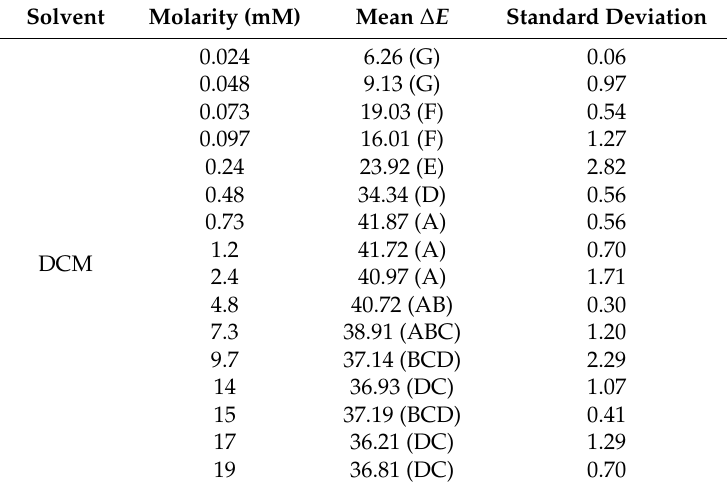
Table 1. Mean ∆ E of the molarities when dissolved in DCM. Different letters classify the data as statistically different within each molarity. DF = 15.